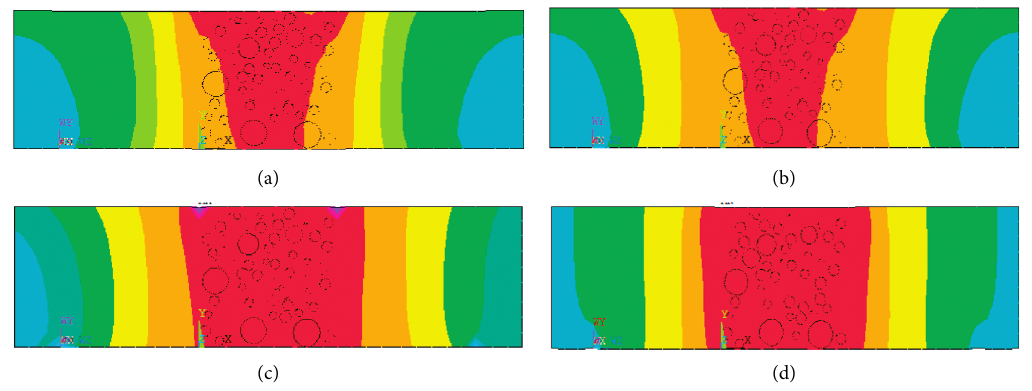
Figure 7: Displacement of the concrete in the direction of Y